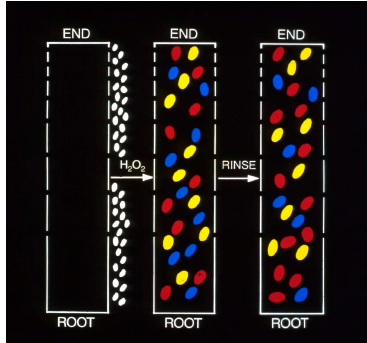
Figure 15. Visualization of interaction of permanent dyes with hair. The dye precursors themselves are colorless.